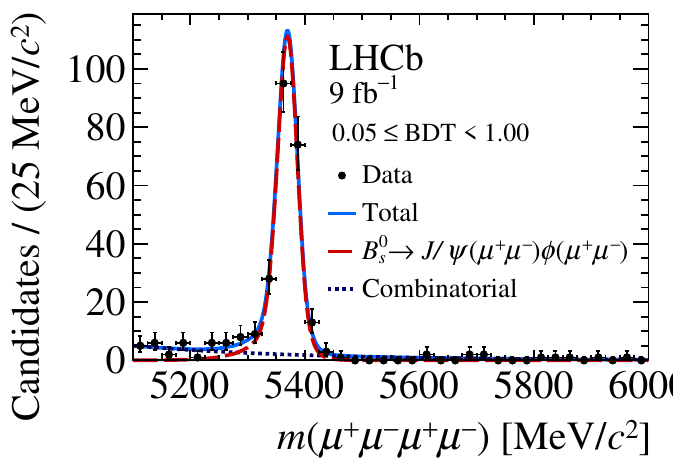
Figure 3 . Distribution of the µ + µ − µ + µ − invariant mass of candidates passing the B 0 → J/ψ ( µ + µ − ) φ ( µ + µ − ) selection, with the fit model used to determine the control sample yield s